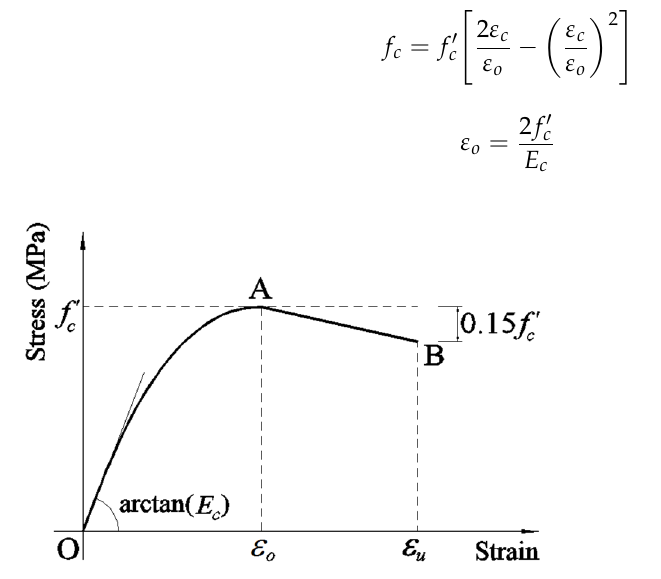
Figure 2. Hognestad [50] model.